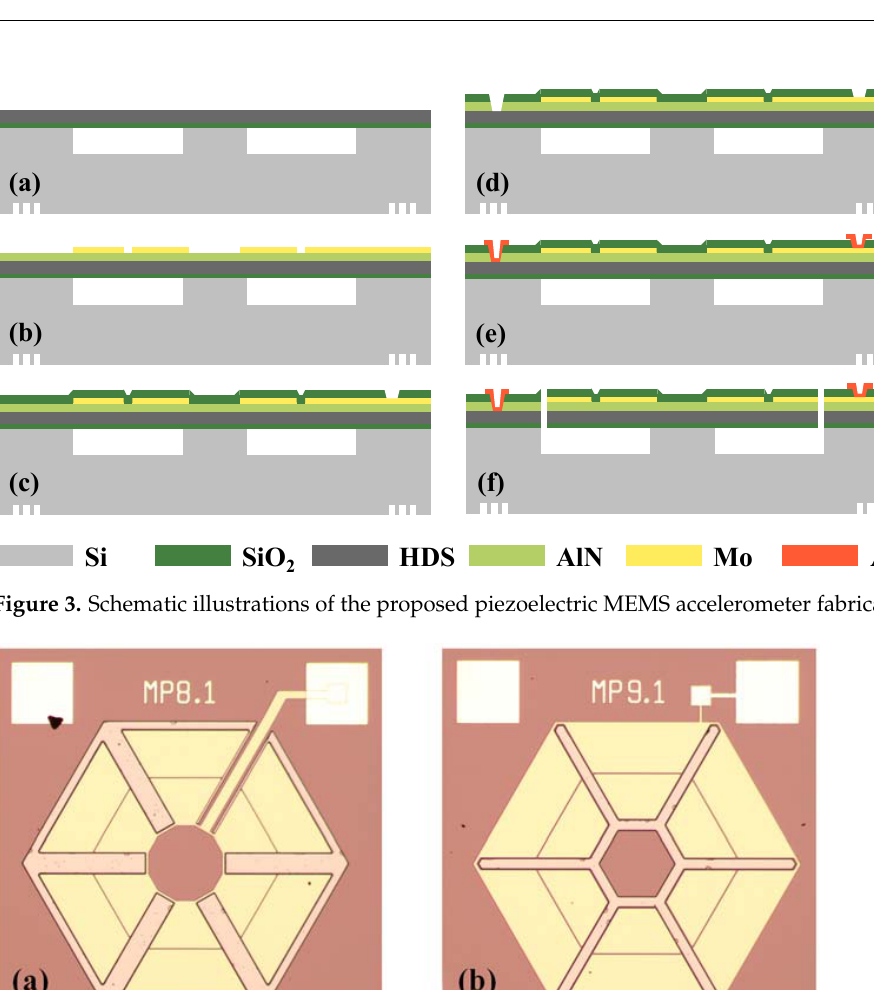
Figure 4. The front view diagram of ( a ) Type A and ( b ) Type B using an optical microscope.